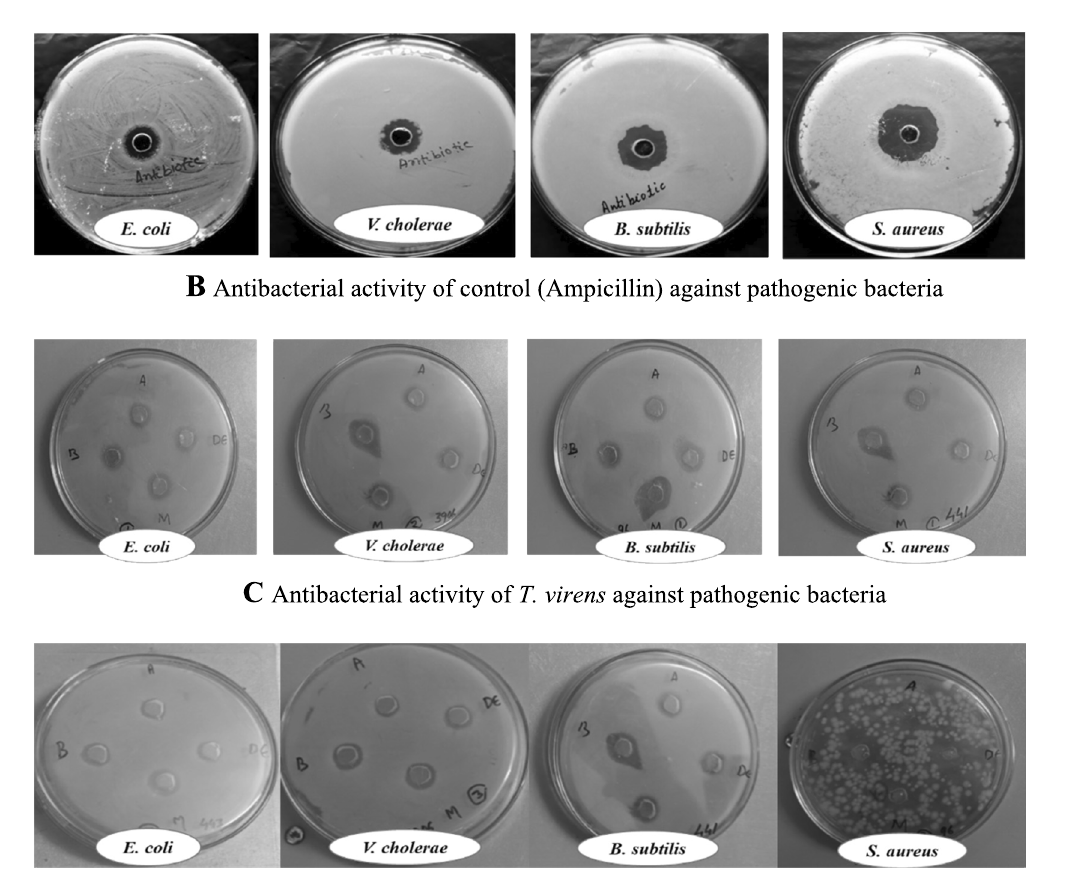
Fig. 10 A Antibacterial activity of lichen against pathogenic bacteria. B Antibacterial activity of control (Ampicillin) against pathogenic bacteria. C Antibacterial activity of T. virens against pathogenic bacteria. D Antibacterial activity of P. dendritica against pathogenic